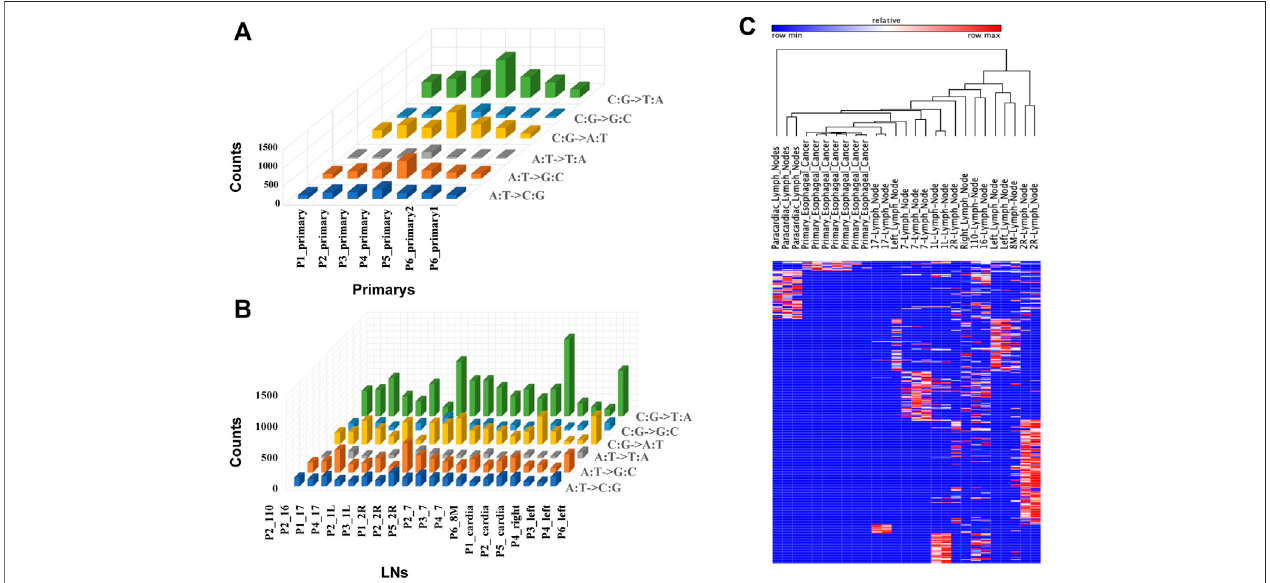
FIGURE2| Somaticmutationsintumorsamples. (A) Histogramofnon-synonymousmutationcountswithmutationfrequencygreaterthan5%inprimarysamples. (B) Histogram of non-synonymous mutation counts with mutation frequency greater than 5% in LN samples. (C) Mutation spectrum of LNs and primary: the column represents the sample, the row represents the site, and each cell represents the mutation count of the sample at that site.